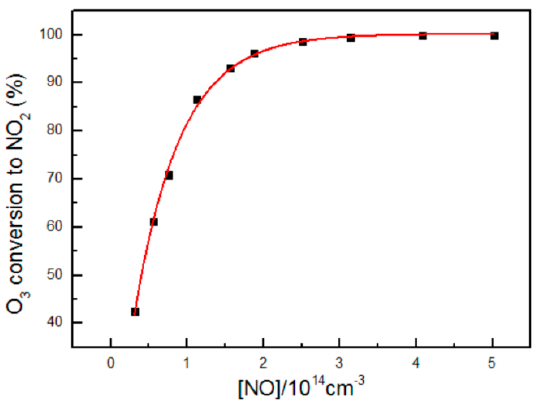
Figure 4. Conversion efficiency of 220 ppbv O 3 to NO 2 as a function of NO concentration.